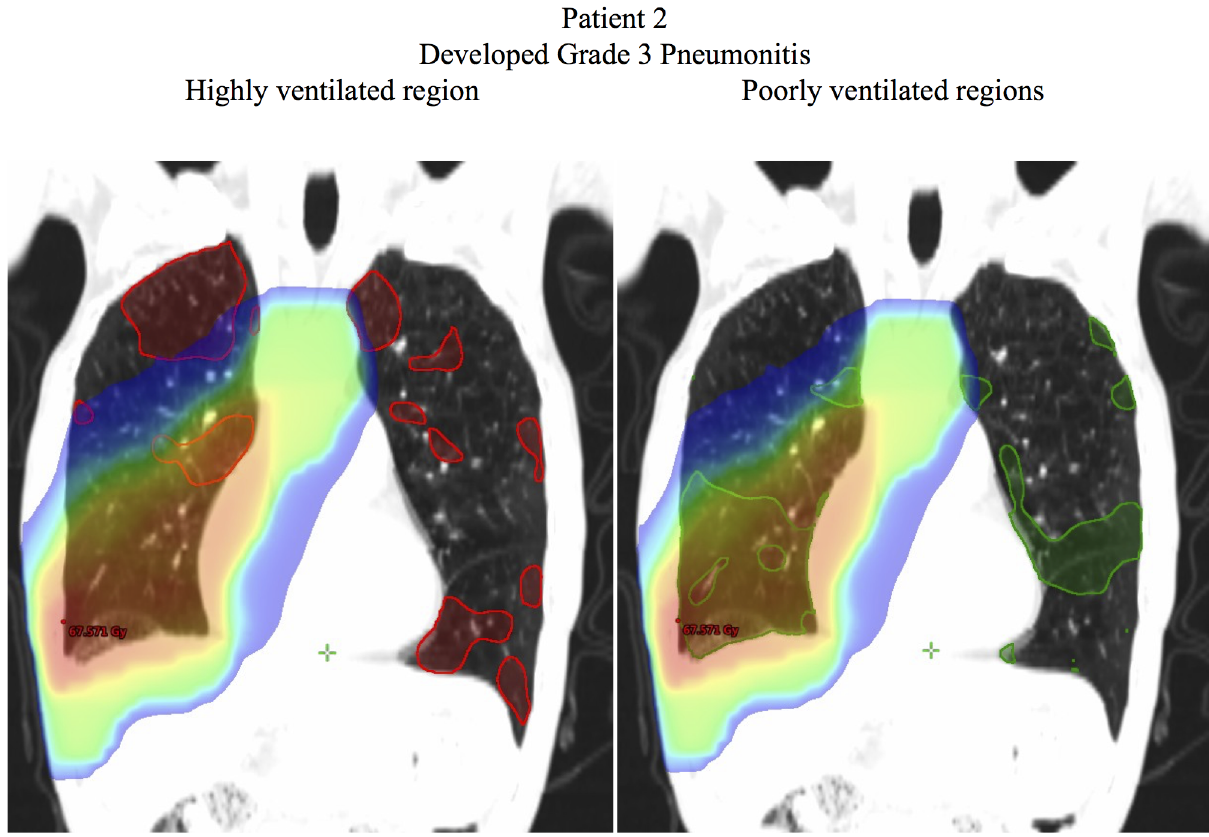
Fig 6. Example case of a patient with severe radiation pneumonitis (Grade 3). The red contour indicates the highly ventilated region (70th–100th percentiles) and the green contour indicates the poorly ventilated region (0–30th percentiles). The dose > 5 Gy is